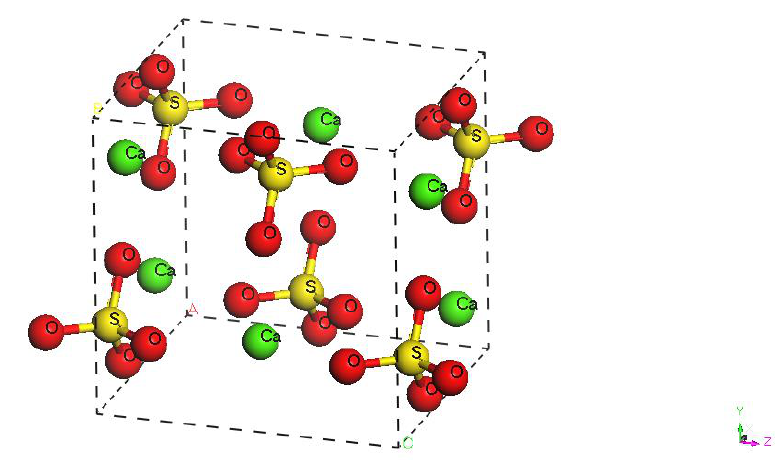
Figure 1. Spatial distribution of atoms in anhydrite unit cell. Table 2. Fractional coordinates of the atoms in the anhydrite unit cell.